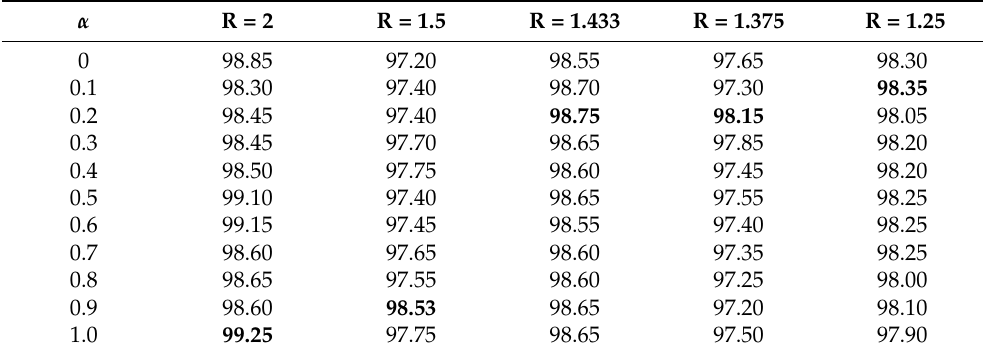
Table 2. Accuracy of elastic information bottleneck (EIB) on simulated data with different noise levels R. The highest accuracy under each noise levels are marked in